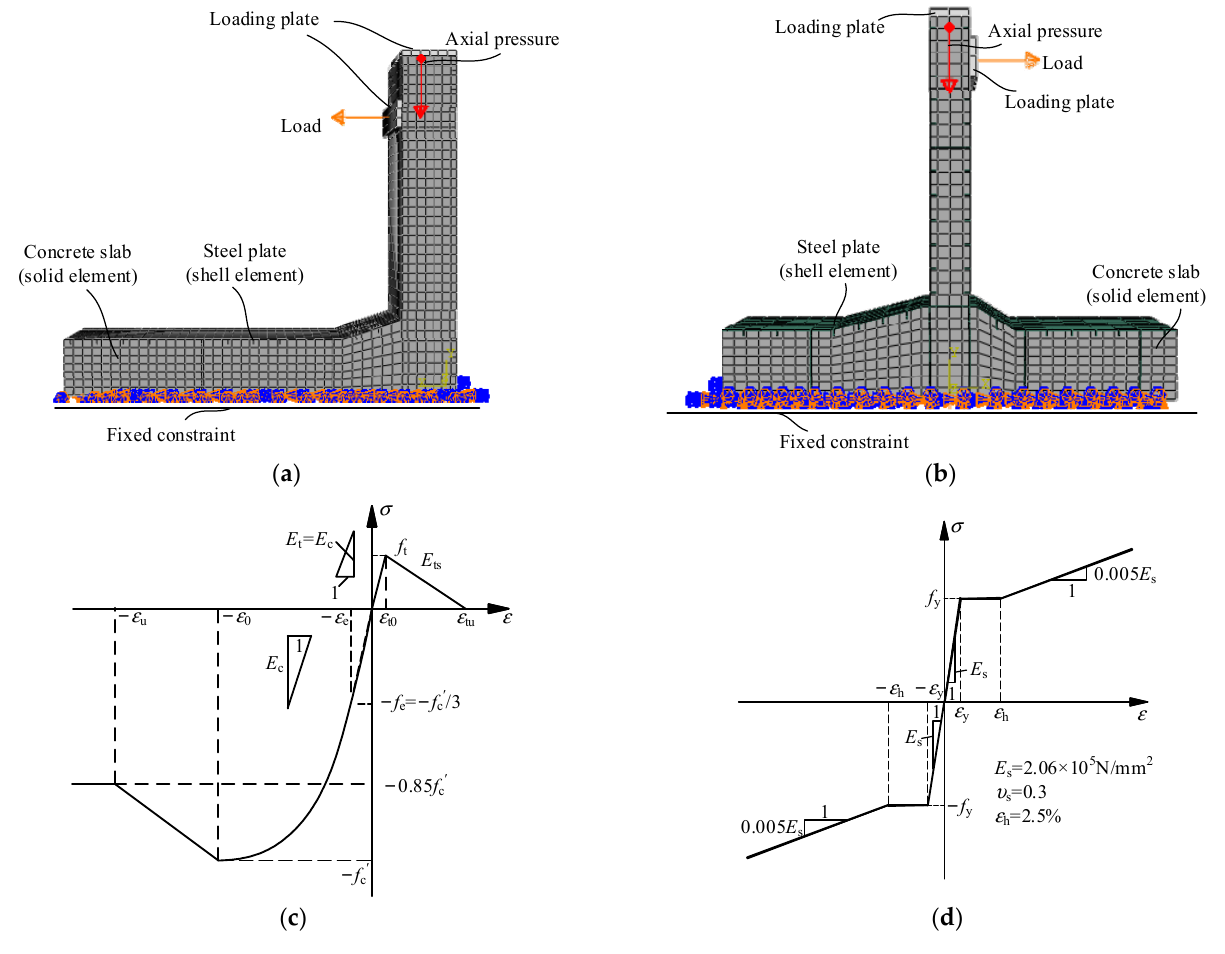
Figure 15. Finite element model of the specimen and material ontology. ( a ) L-shaped specimen; ( b ) T-shaped specimen; ( c ) concrete principal structure; ( d ) steel principal structure.